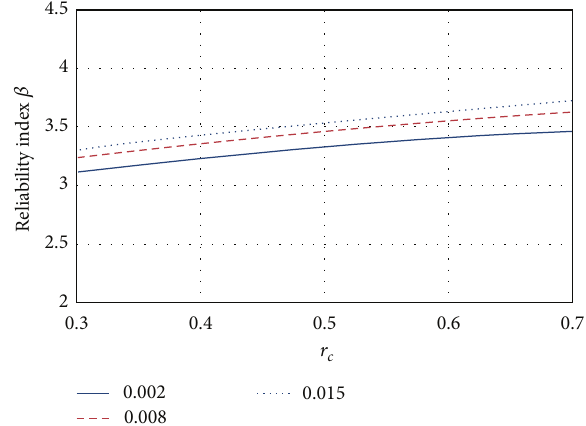
Figure 4: Influence on the structural reliability of the longitudinal reinforcement 𝜌 𝑔 .